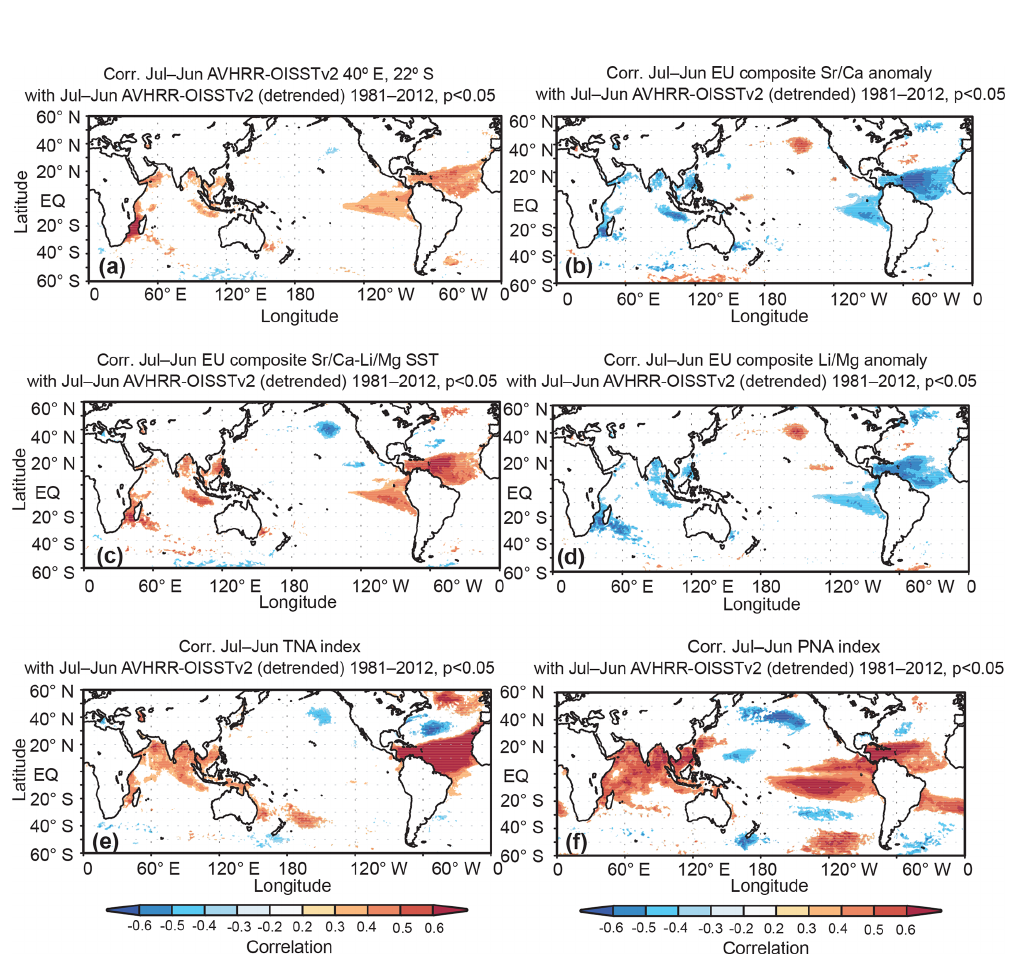
Figure 10. Spatial correlations of proxy-based coral composite SST reconstructions with local and global AVHRR-OISSTv2 for mean annual data (Banzon et al., 2016). (a) Local AVHRR-OISSTv2 with global AVHRR-OISSTv2, (b) local AVHRR-OISSTv2 with EU composite Sr / Ca–Li / Mg SST, (c) local AVHRR-OISSTv2 with EU composite Sr / Ca ratios, and (d) local AVHRR-OISSTv2 with EU composite Li / Mg ratios. Panels (e) and (d) show spatial correlations of the TNA and PNA indices with global AVHRR-OISSTv2. Only correlations with p < 0 . 05 were colored.